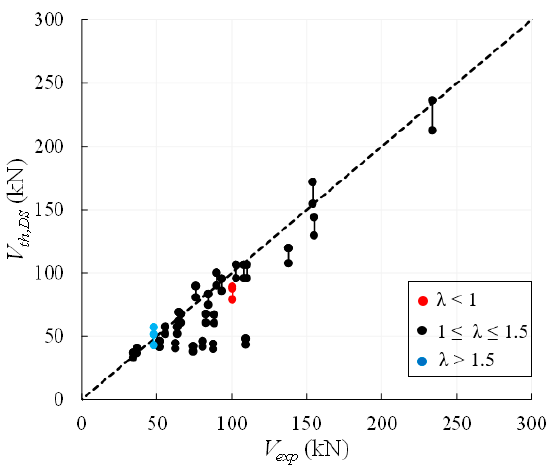
Figure 12. Experimental vs. theoretical results for irregular masonry walls collected by slenderness.